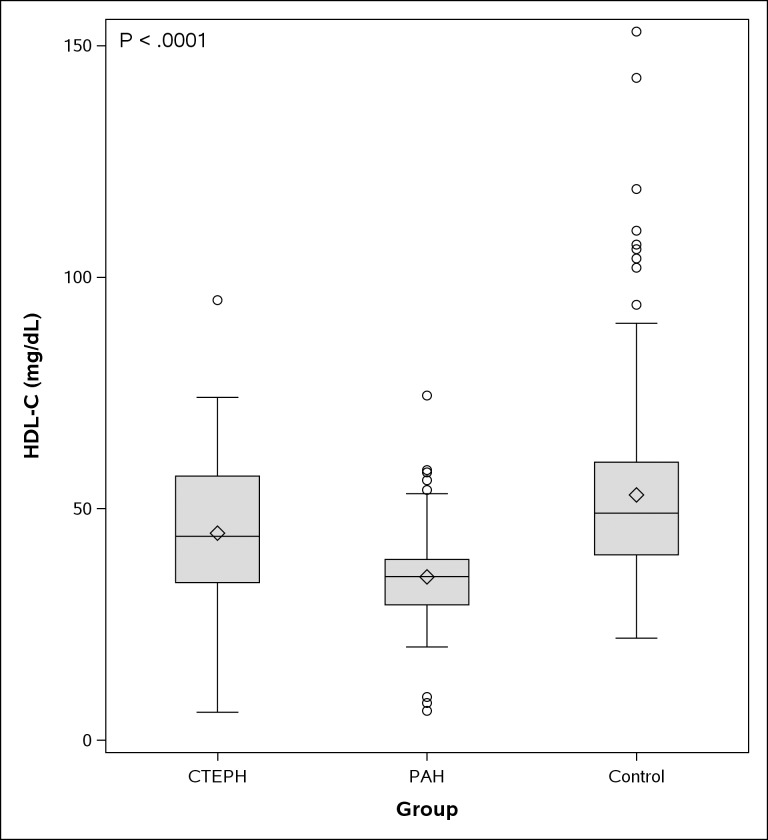
Mean plasma HDL-C (mg/dL) in 3 groups of patients (CTEPH, PAH and control group).HDL-C in CTEPH patients is lower compared to control subjects and higher compared to PAH patients. (Mean± SD): CTEPH: (44.7 ± 15.5 mg/dL); PAH: (35.2±11.5 mg/dL); Control: (52.9 ±19.7 mg/dL); p < 0.0001 for the ANOVA test that was performed to compare mean HDL-C among the three groups of patients. P values for post hoc pairwise comparisons were: CTEPH vs PAH: <0.001, CTEPH vs control: <0.001, PAH vs control: <0.001. Circle symbol represents outliers, diamond symbol represents mean HDL-C values, error bars showing SD of the mean.